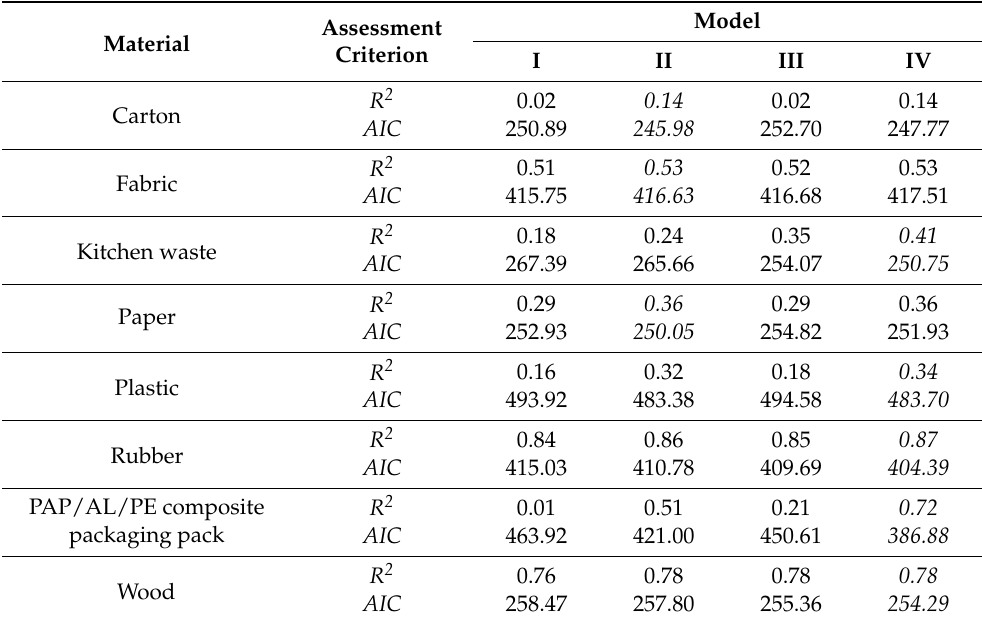
Table 3. Results of regression models of HHV of CSF determined from RDF components in relation to pyrolysis temperature and residence